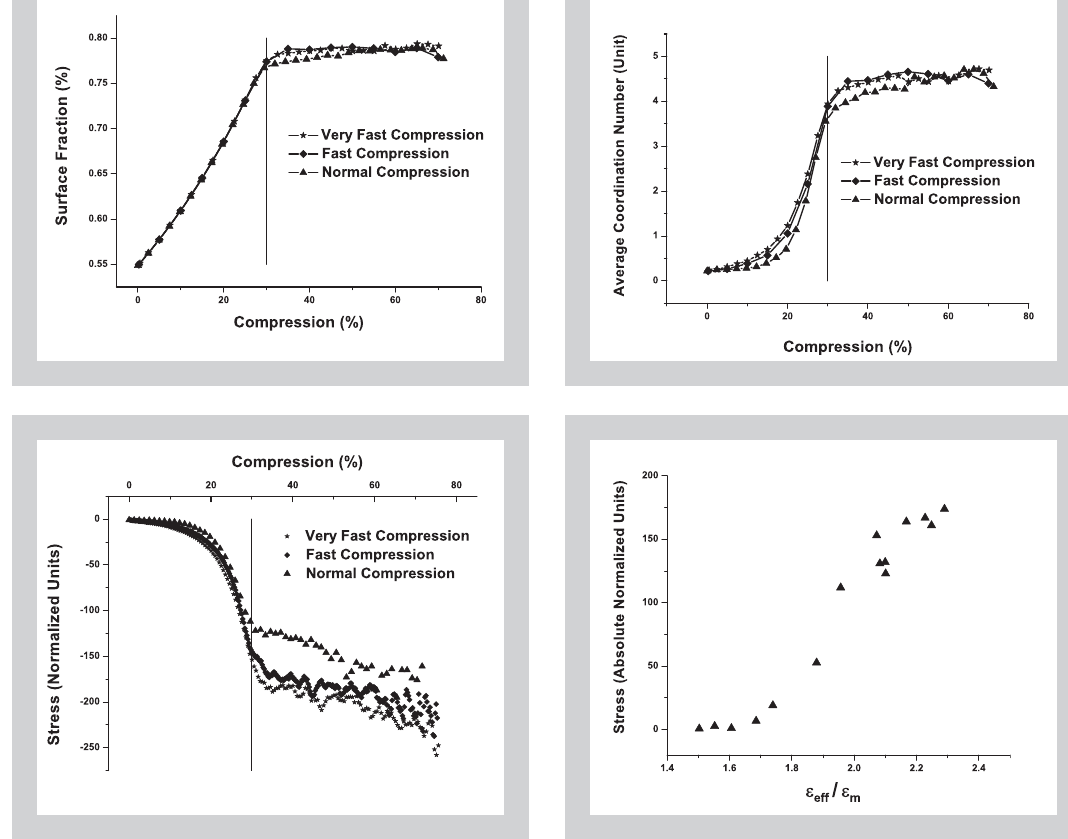
Figure 7: Evolution of the surface area, covered by the parti- cles at the surface, against the percentage area reduc- tion for the three different compression rates: 10 -4 ( ¯ ), 5·10 -5 ( Ï ) and 10 -5 ( Ú ) in inverse simulation time unit. Figure 8: Evolution of the average coordination number against the percentage area reduction for the three dif- ferent compression rates: 10 - 4 ( ¯ ), 5·10 -5 ( Ï ) and 10 -5 ( Ú ) in inverse simulation time unit. Figure 9: Value of stress in the direc- tion of compression, for the different compression rates: 10 -4 ( ¯ ), 5·10 -5 ( Ï ) and 10 -5 ( Ú ) in inverse simulation time unit. Figure 10: Correlation between the mechanical properties (Stress in absolute normal- ized units, in the direction of the compression) and the dielectric constant, for the slowest simulation involv- ing a compression rate of 10 - 4 per unit simulation